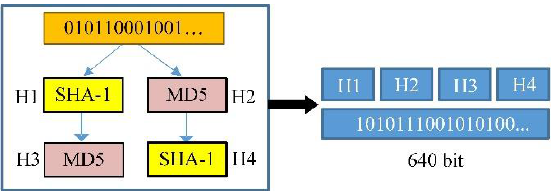
Figure 5. Flow of applying hash functions.